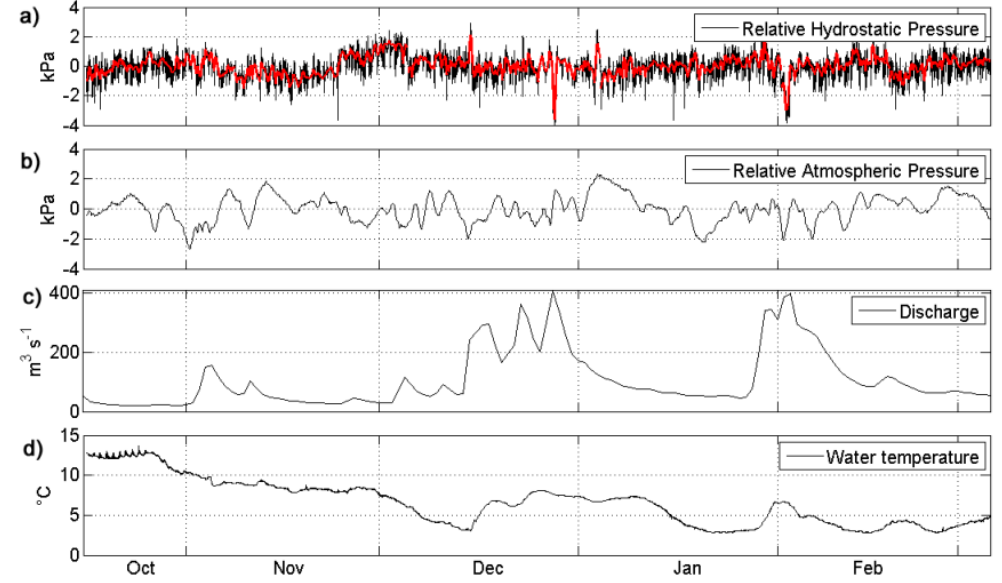
Figure 3. (a) Relative hydrostatic (original data in black, low-frequency filtered in red), (b) atmospheric pressure, (c) discharge and (d) water temperature between 16 October 2012 and 6 March 2013.